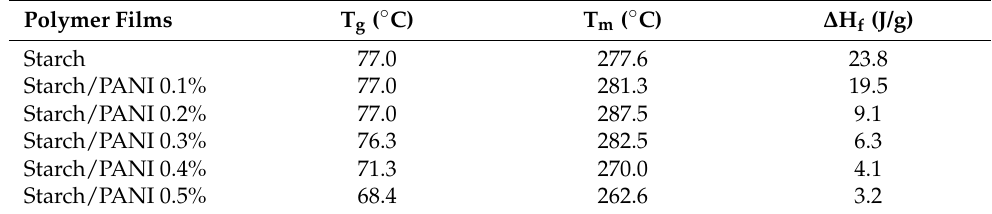
Table 2. The glass-transition temperature (T g ), melting temperature ™, and enthalpy of fusion ( ∆ H f ) of starch and starch/PANI (0.1%, 0.2%, 0.3%, 0.4%, 0.5%)-polymer